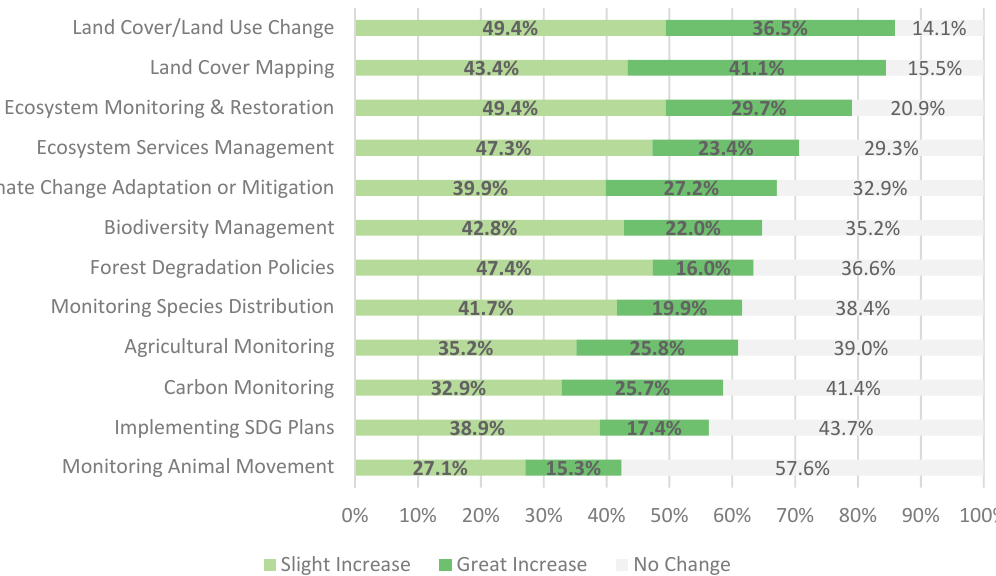
Figure 9. Change in use of RSD as a result of ARSET for land applications. Light green = slight increase; dark green = great increase; gray = participants for whom the task was applicable, but who indicated no change in their use of RSD for that task ( N = 144–178, with 0–34 claiming the task was not applicable).